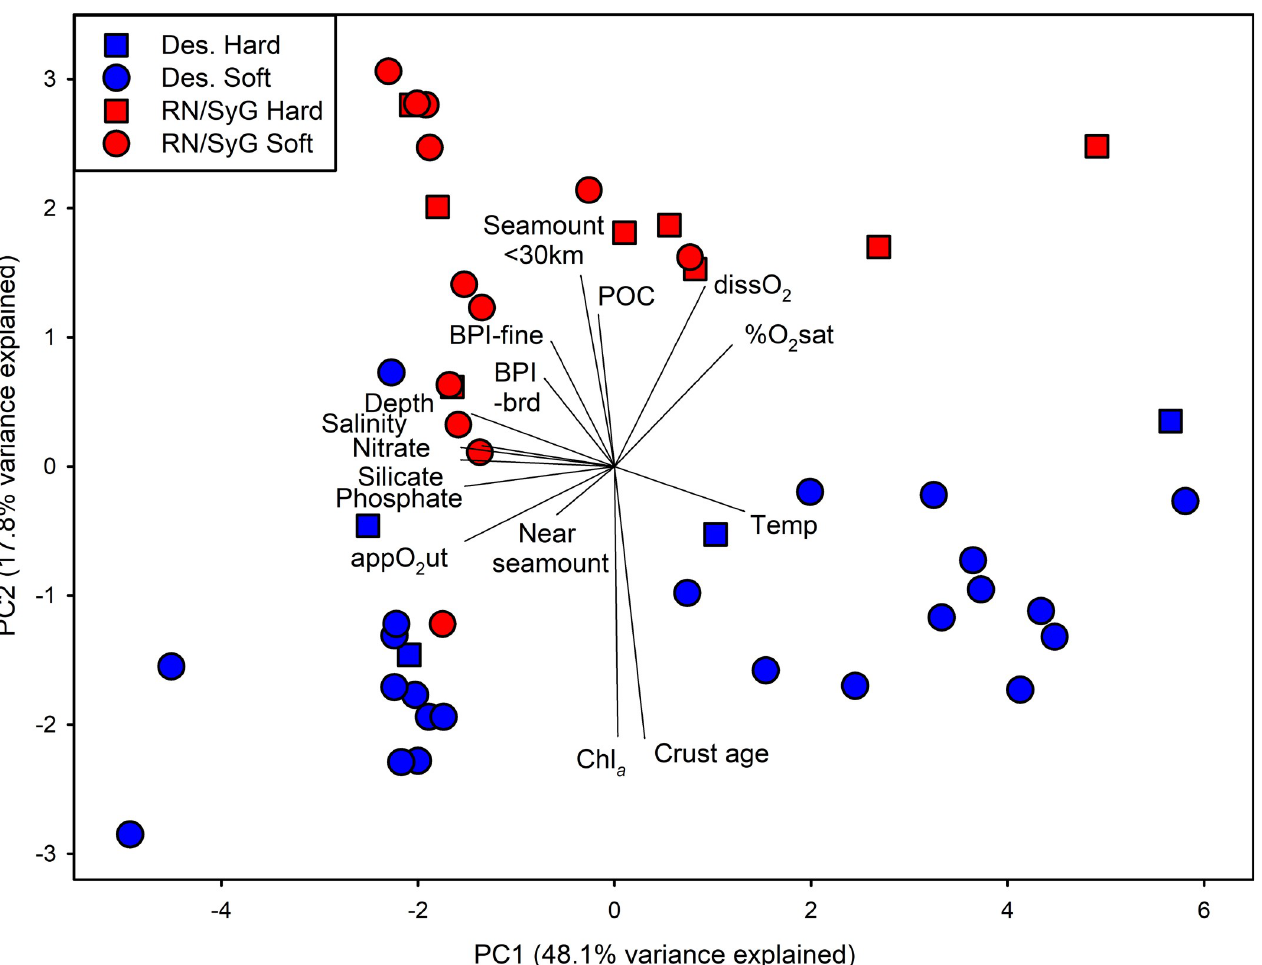
Fig 4. Principal Components Analysis (PCA) of environmental variables at camera deployment sites. Data were Box-Cox transformed prior to analysis. Des. = Desventuradas.